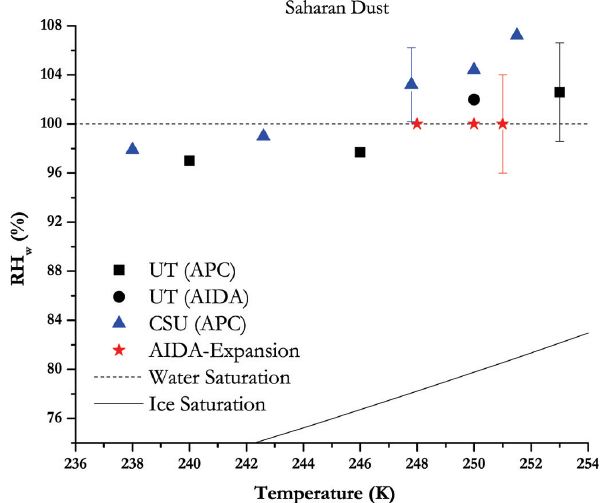
Fig. 5. Same as Fig. 4 but for CID. Dotted line: homogeneous freezing conditions for 0.1% 300nm ammonium sulphate aerosols in 10s (DeMott et al.,